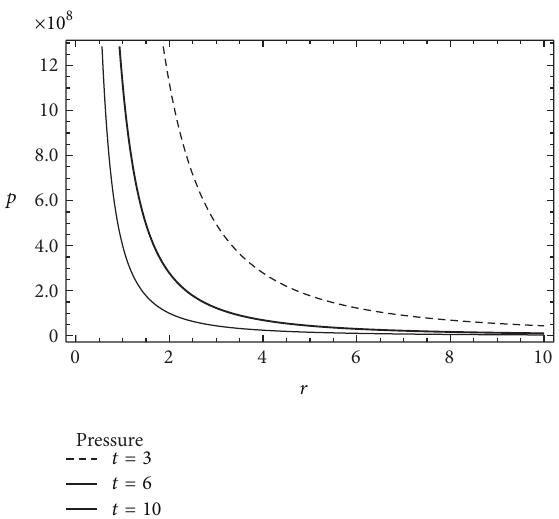
Figure 4: The radial profile for the pressure 𝑝 at various units of